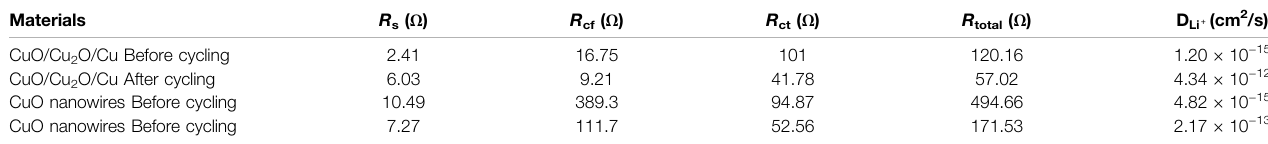
TABLE 2 | The fi tted resistance parameters of electrochemical impedance spectroscopy and the Li-ions diffusion coef fi cients before and after cycling. Materials